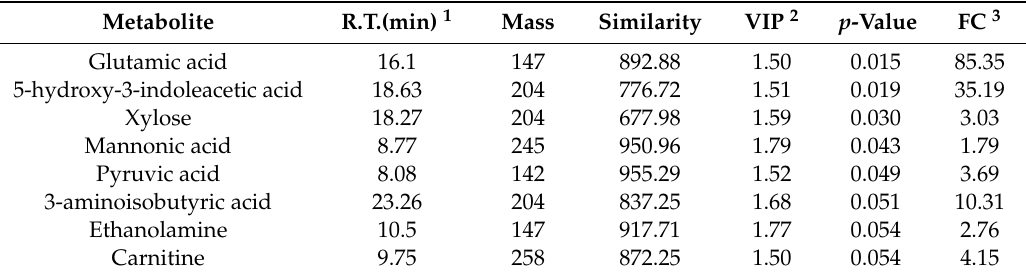
Table 8. List of significantly changed metabolites between the Con group and the OT group.